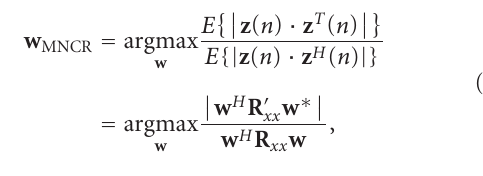
Figure 1: Block diagram of the GPS